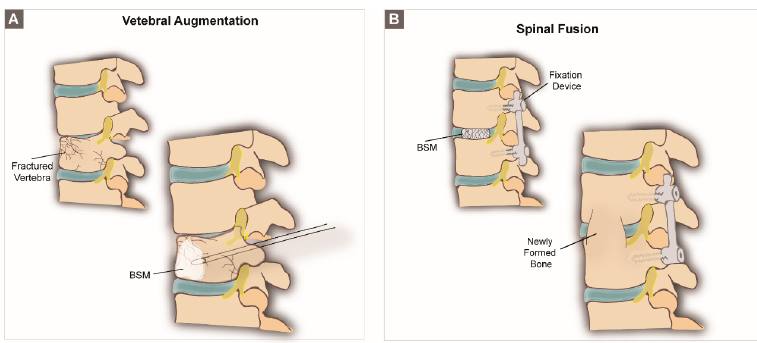
Figure 5. Schematic representation of ( A ) a vertebral augmentation procedure and ( B ) a spinal fusion procedure.